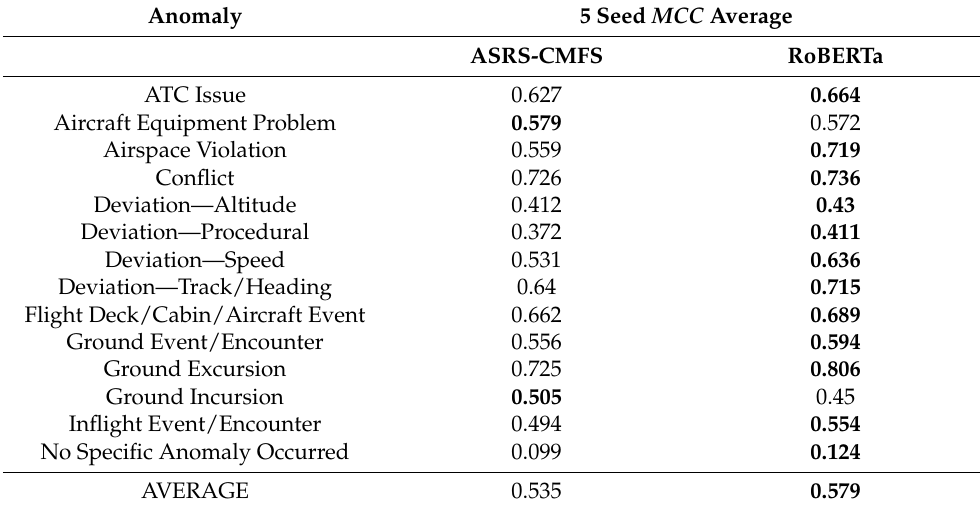
Table 10. The results for the different classification problems, the best results are in